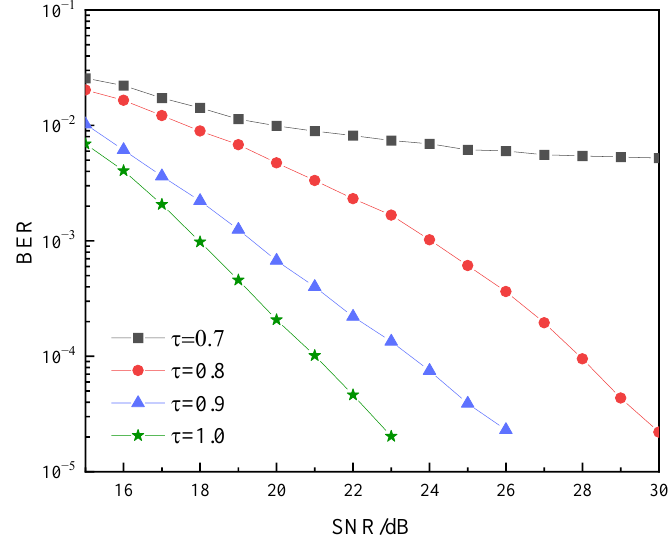
Figure 8. Relationship of BER and acceleration factor 